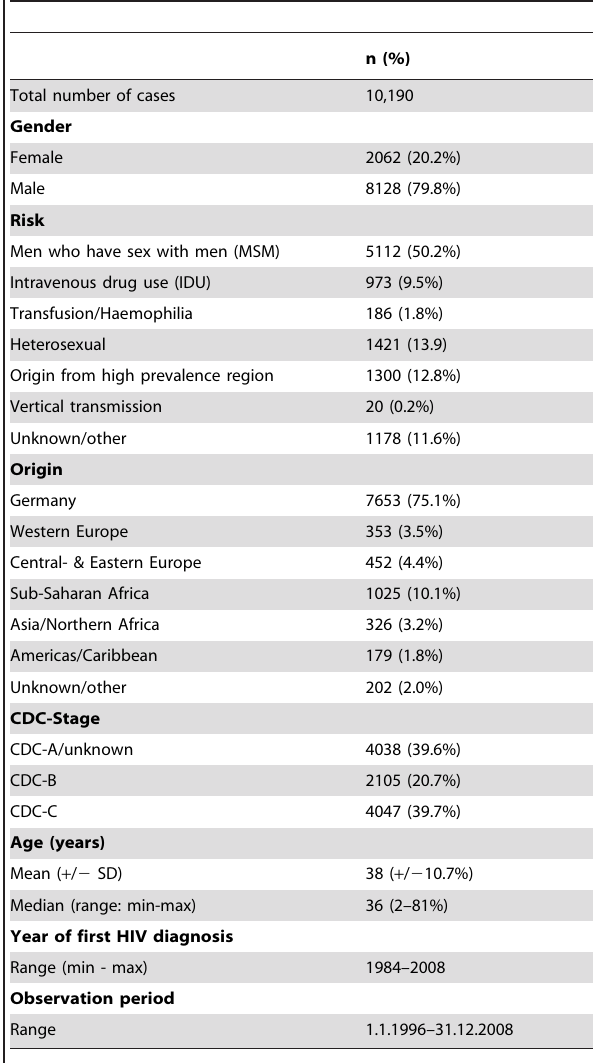
Table 2. Patients’ characteristics at the time when their first cART regimen was documented within the ClinSurv